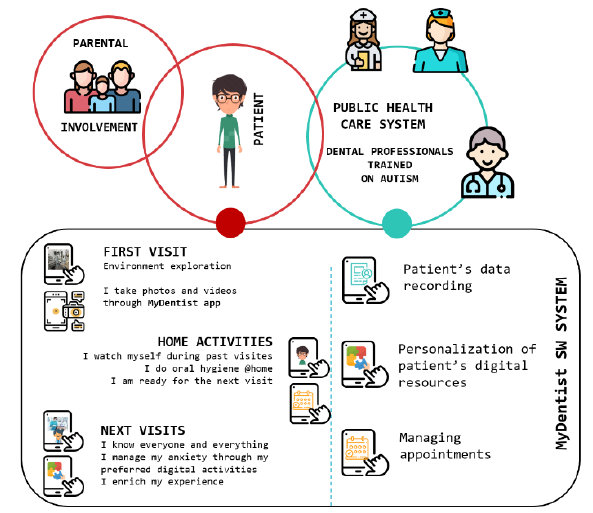
Figure 2. MyDentist global view.